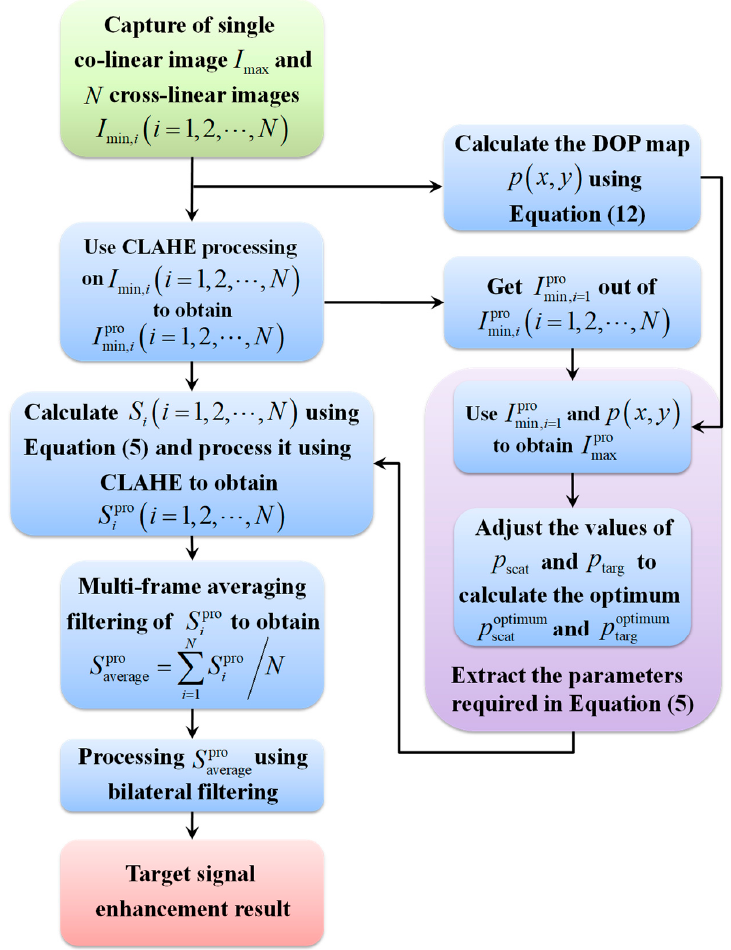
Figure 3. The flowchart of underwater polarization differential imaging enhancement based on CLAHE cross-linear image histogram equalization and joint noise suppression.